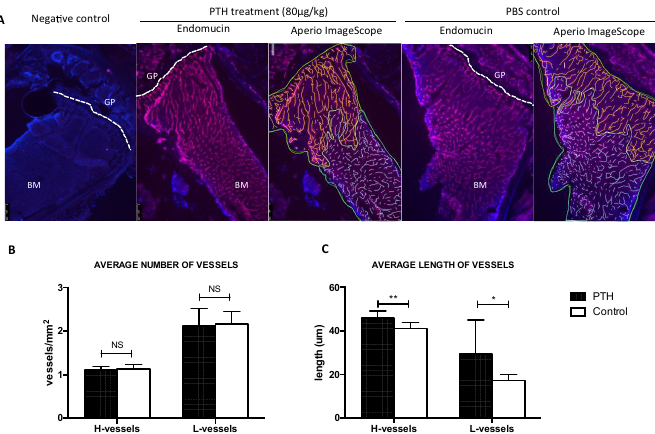
Figure A2. Effects of 80 μg/kg PTH on the bone microvasculature. ( A ) Tibia sections of animals from control and PTH treated animals ( n = 5/group) were stained with antibody against the endothelial cell marker Endomucin (in red), nuclei were counterstained with DAPI (blue) (GP = growth plate, BM = bone marrow). Aperio ImageScope images show the quantification of the vessels performed manually (green = area of bone marrow analyzed, yellow = H-vessels, blue = L-vessels). Number of H- and L-vessels in both groups are shown in ( B ) while the average vessel length is shown in ( C ). Graphs show mean ± SEM, * p < 0.05 and ** p < 0.005 by 2 way